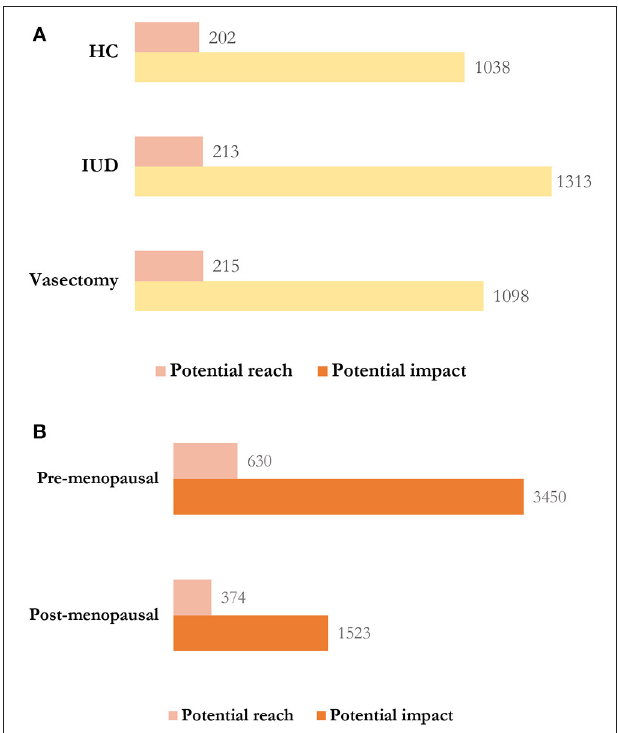
FIGURE 2 | (A) Potential impact and potential reach of the pre-menopause tweets (in millions). HC, hormonal contraception; IUD, intrauterine device. (B) Potential impact and potential reach comparisons between pre-menopause and post-menopause treatments (in millions).